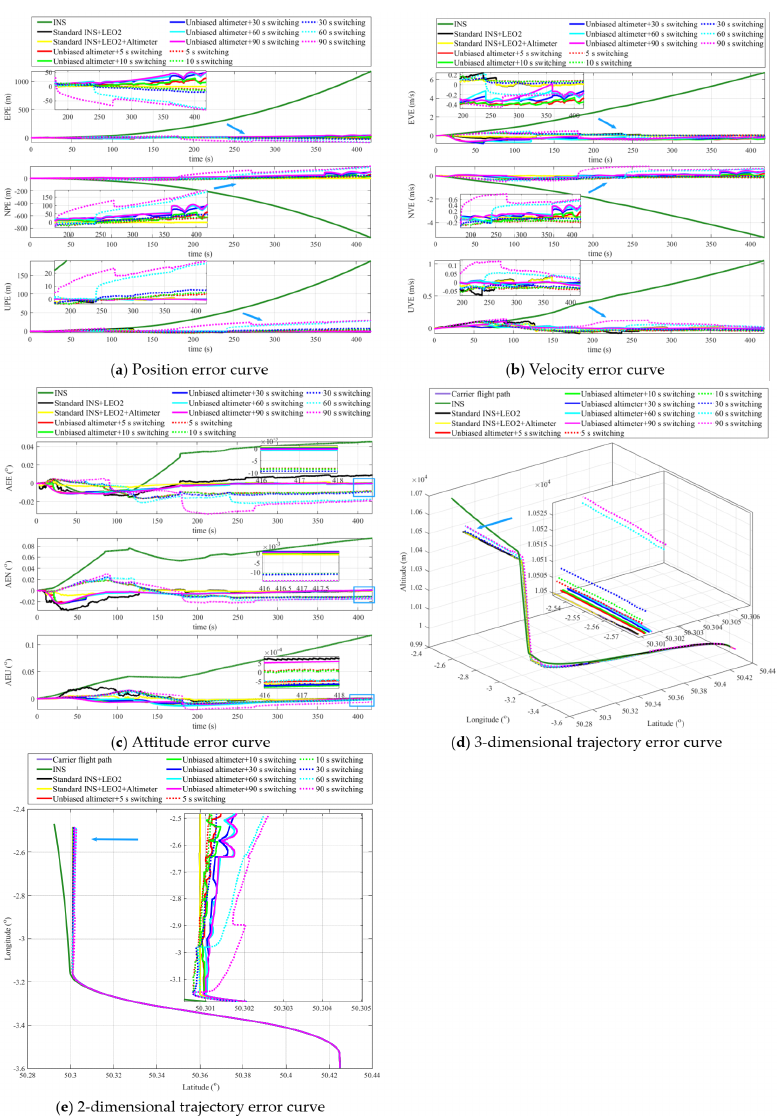
Figure 4. Experimental results of INS + LEO2 + unbiased altimeter and no altimeter scenarios under the same